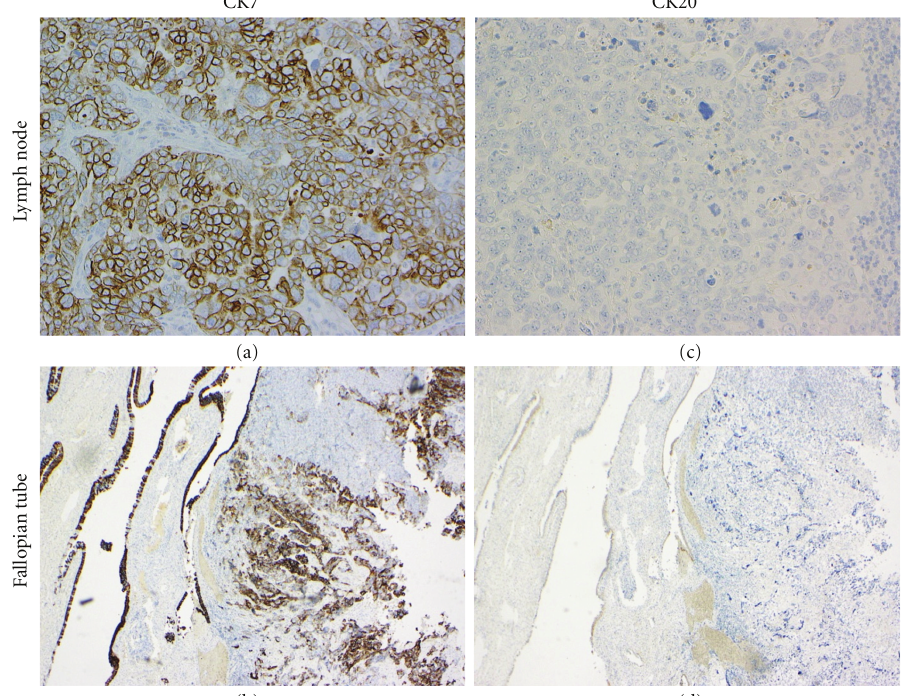
Figure 3: Crisp staining of tumour in the lymph node and the Fallopian tube with CK7 ((a) and (b)) and negative staining for CK20 for the same tumour at both sites ((c) and